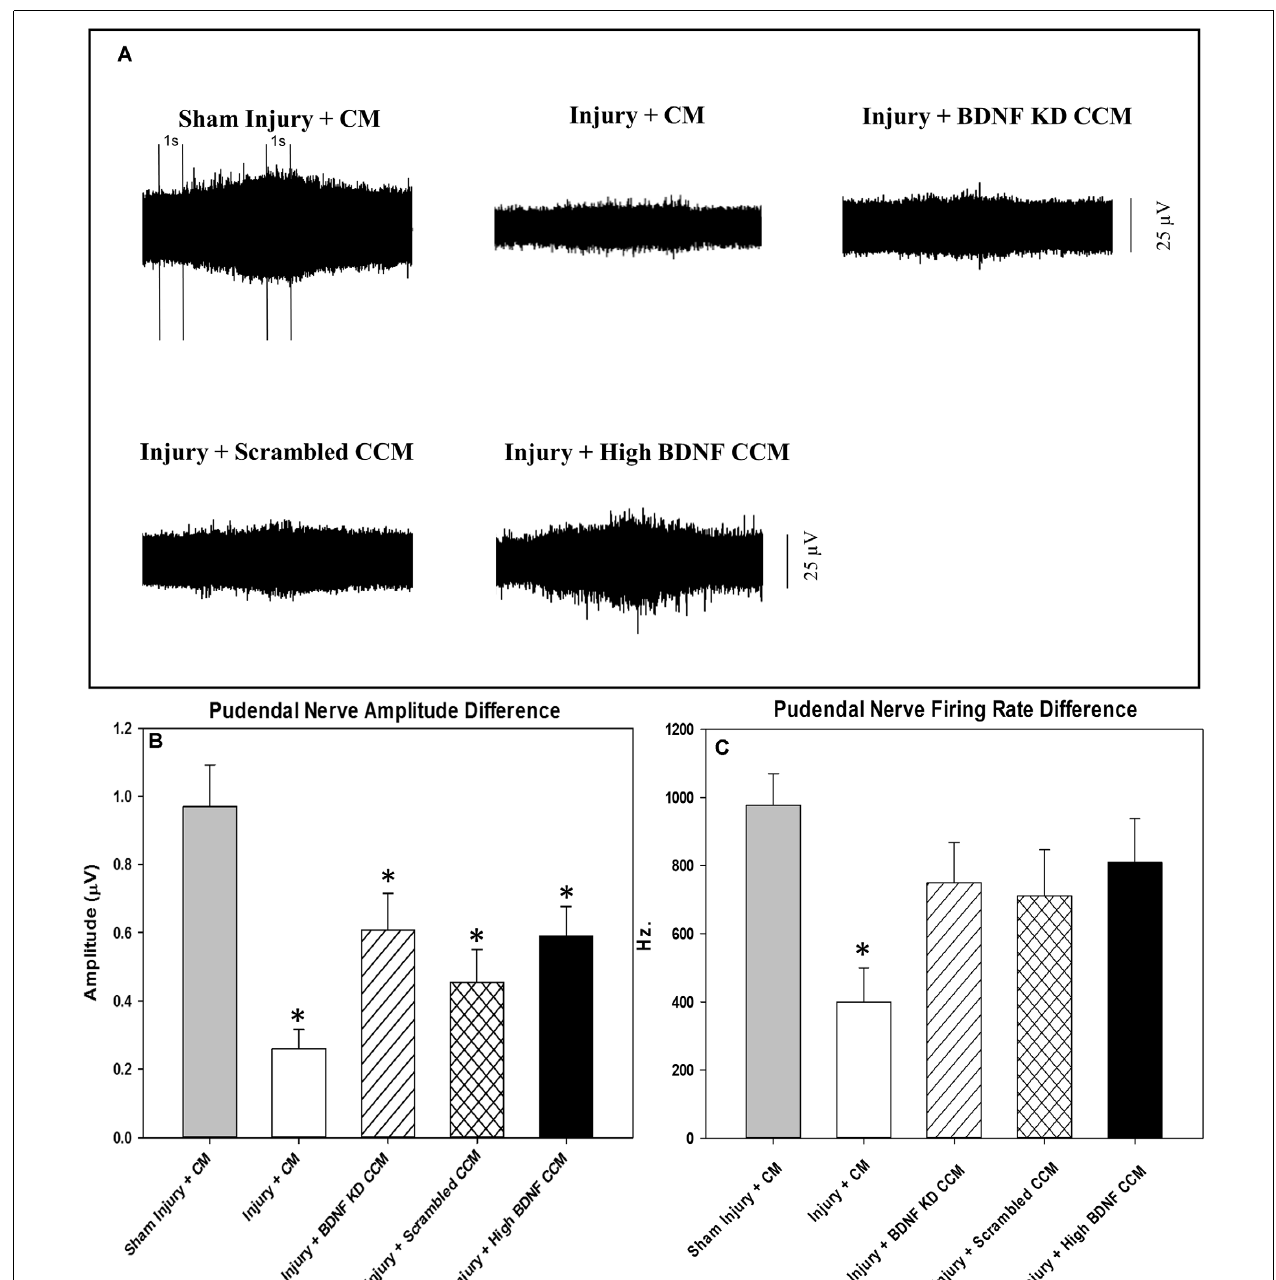
FIGURE 4 | Pudendal nerve sensory branch results. Examples of sensory nerve recording from each group: Sham Injury + Control Media (CM), Injury (Pudendal Nerve Crush + Vaginal Distension) + CM, Injury + Brain-Derived Neurotrophic Factor Knockdown (BDNF KD) Concentrated Conditioned Media (CCM), Injury + Scrambled CCM, or Injury + High BDNF CCM (A) .The vertical dashed lines show where 1-s recording segments were selected at baseline and during brushing for analysis. Quantitative sensory nerve testing results of Amplitude (B) and Firing Rate (C) . Each bar represents the mean ± standard error of the mean of 12 animals per group. ANOVA followed by a Student-Newman-Keuls post-hoc test was used to indicate significant differences. ∗ Indicates a statistically significant difference compared to Sham Injury +